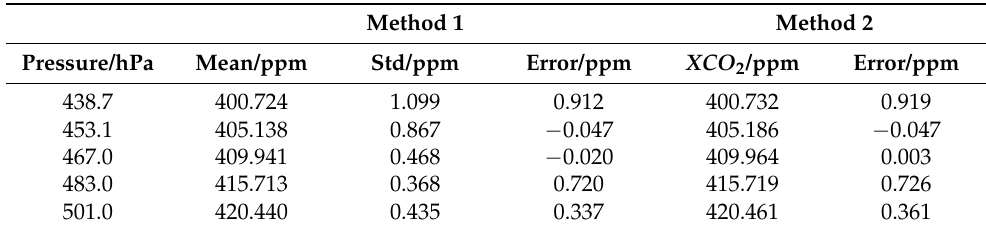
Figure 13. The retrieval results of 15 periods at ( a ) 438.7 hPa; ( b ) 453.1 hPa; ( c ) 467 hPa; ( d ) 483 hPa; ( e ) 501 hPa, respectively. The actual retrieval results (blue dot), averages of retrieval results (green dotted-line) and true values (red line) are shown.